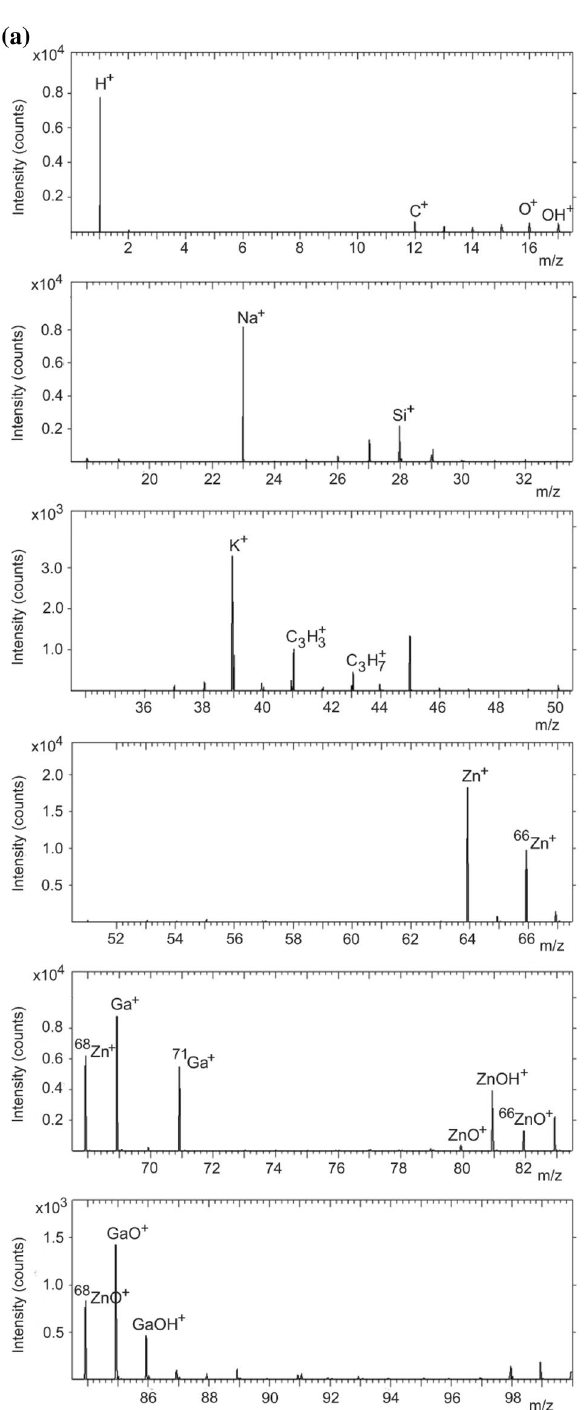
Figure 2. Positive secondary ion spectrum for the ( a ) 1 wt% and ( b ) 7 wt% GZO